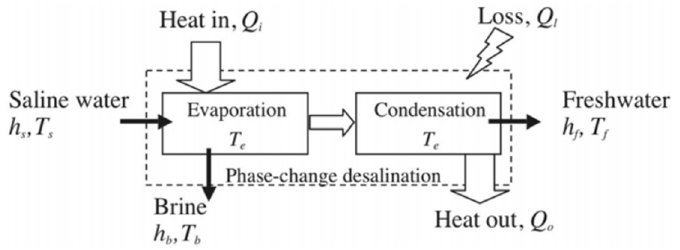
Figure 1. Generic phase-change desalination process with energy flows [19].